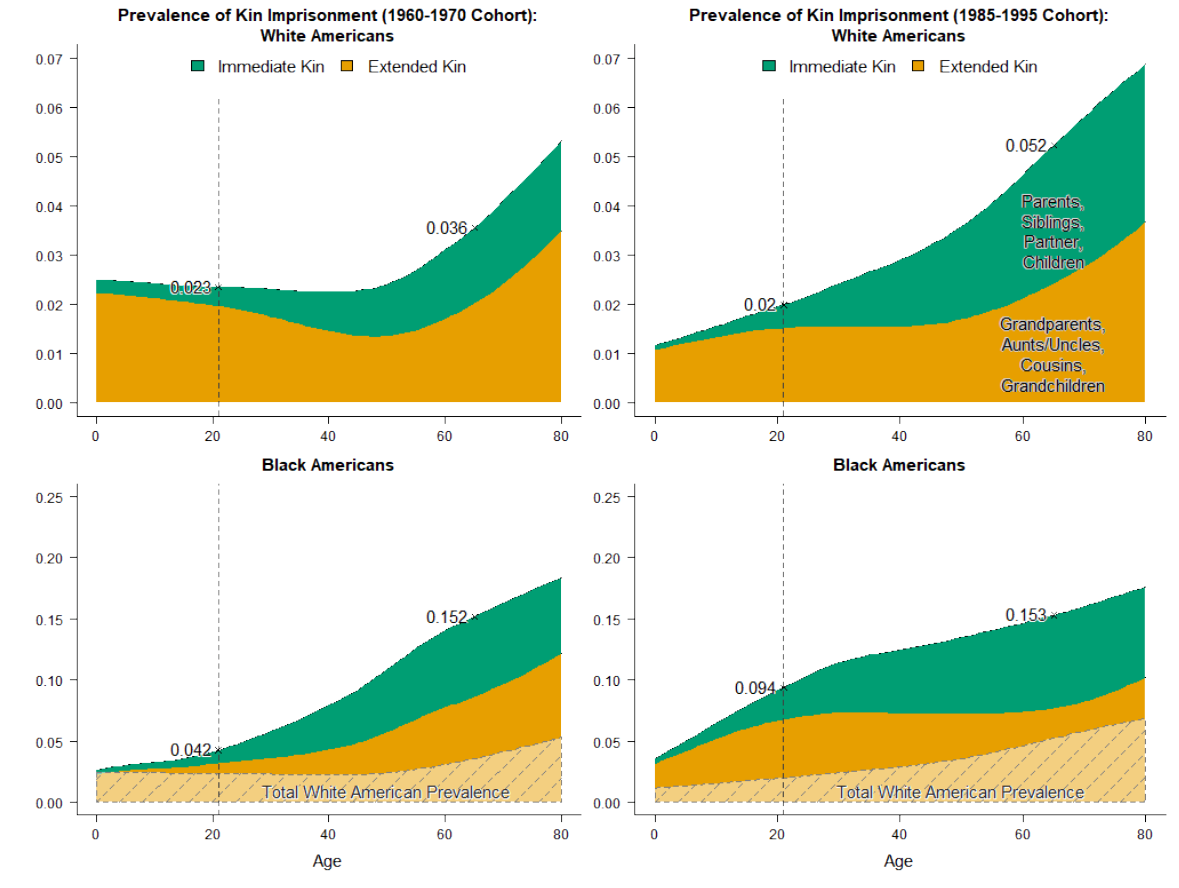
Figure 2: Cohort-specific prevalence of incarceration within kinship networks over age (by relation). The top plots illustrate the proportion of living kin who have ever been incarcerated for white individuals, whereas the bottom plots illustrate the same for black individuals. Points marked by x’s indicate the proportion of kin ever incarcerated when ego is age 21 and 65. The total prevalence of incarcerated kin in the white population is superimposed on the bottom (black population) plots to aid comparison across the two different y axis